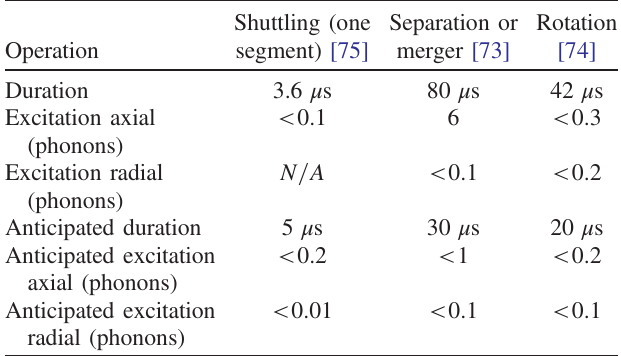
TABLE IV. Current and anticipated metrics for different shut- tling operations, carried out with 40 Ca þ ions in a multilayer trap (see Sec. III and lower inset of Fig. 1). The axial trap frequency is about 2 π × 1 . 4 MHz, while the radial frequencies are around 2 π × 3 MHz. The shuttling is carried out with one ion, while the other operations are carried out with two ions. Note that the 3 . 6 - μ s duration for low-excitation shuttling is obtained with an amplitude- and phase-calibrated deexcitation kick [75]. Since shuttling duration will not be the bottleneck as compared to other operations, we can anticipate a slightly longer duration of 5 μ s with similar low excitations, but a smaller calibration